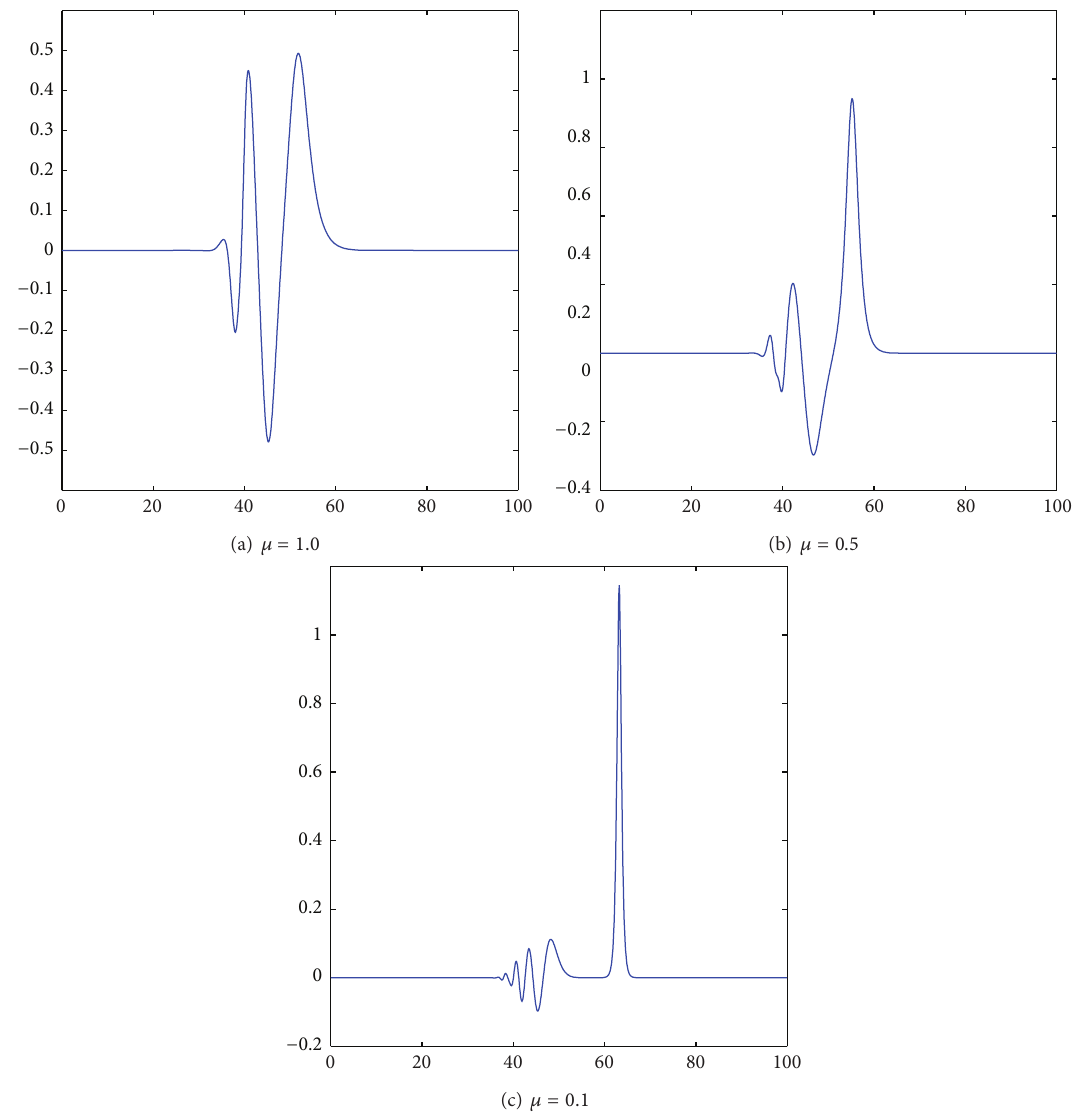
Figure 7: Maxwellian initial condition with different values 𝜇